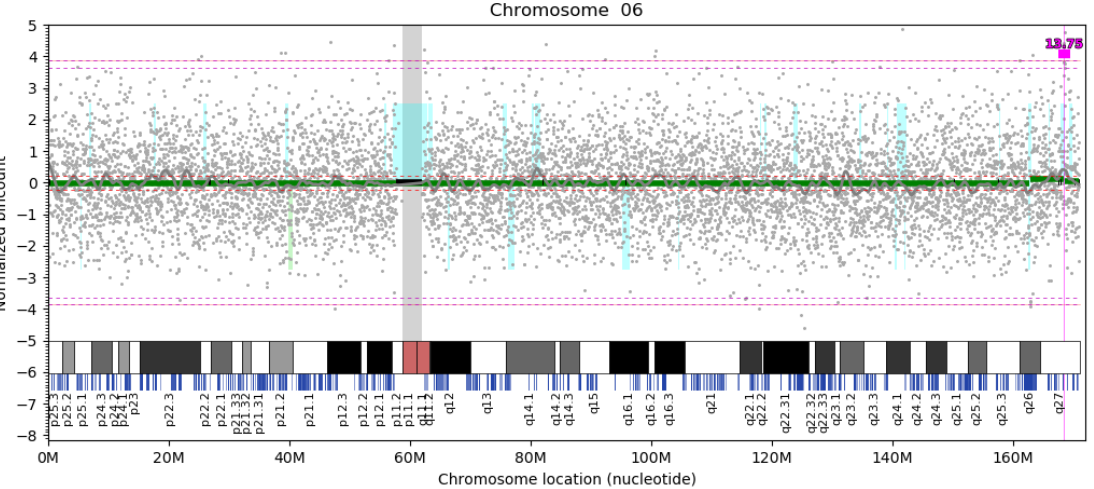
Figure 2. The most frequent MOV dup 6q7 in the dataset of 6422 analyses is localized in the terminus of the long arm of chromosome 6.